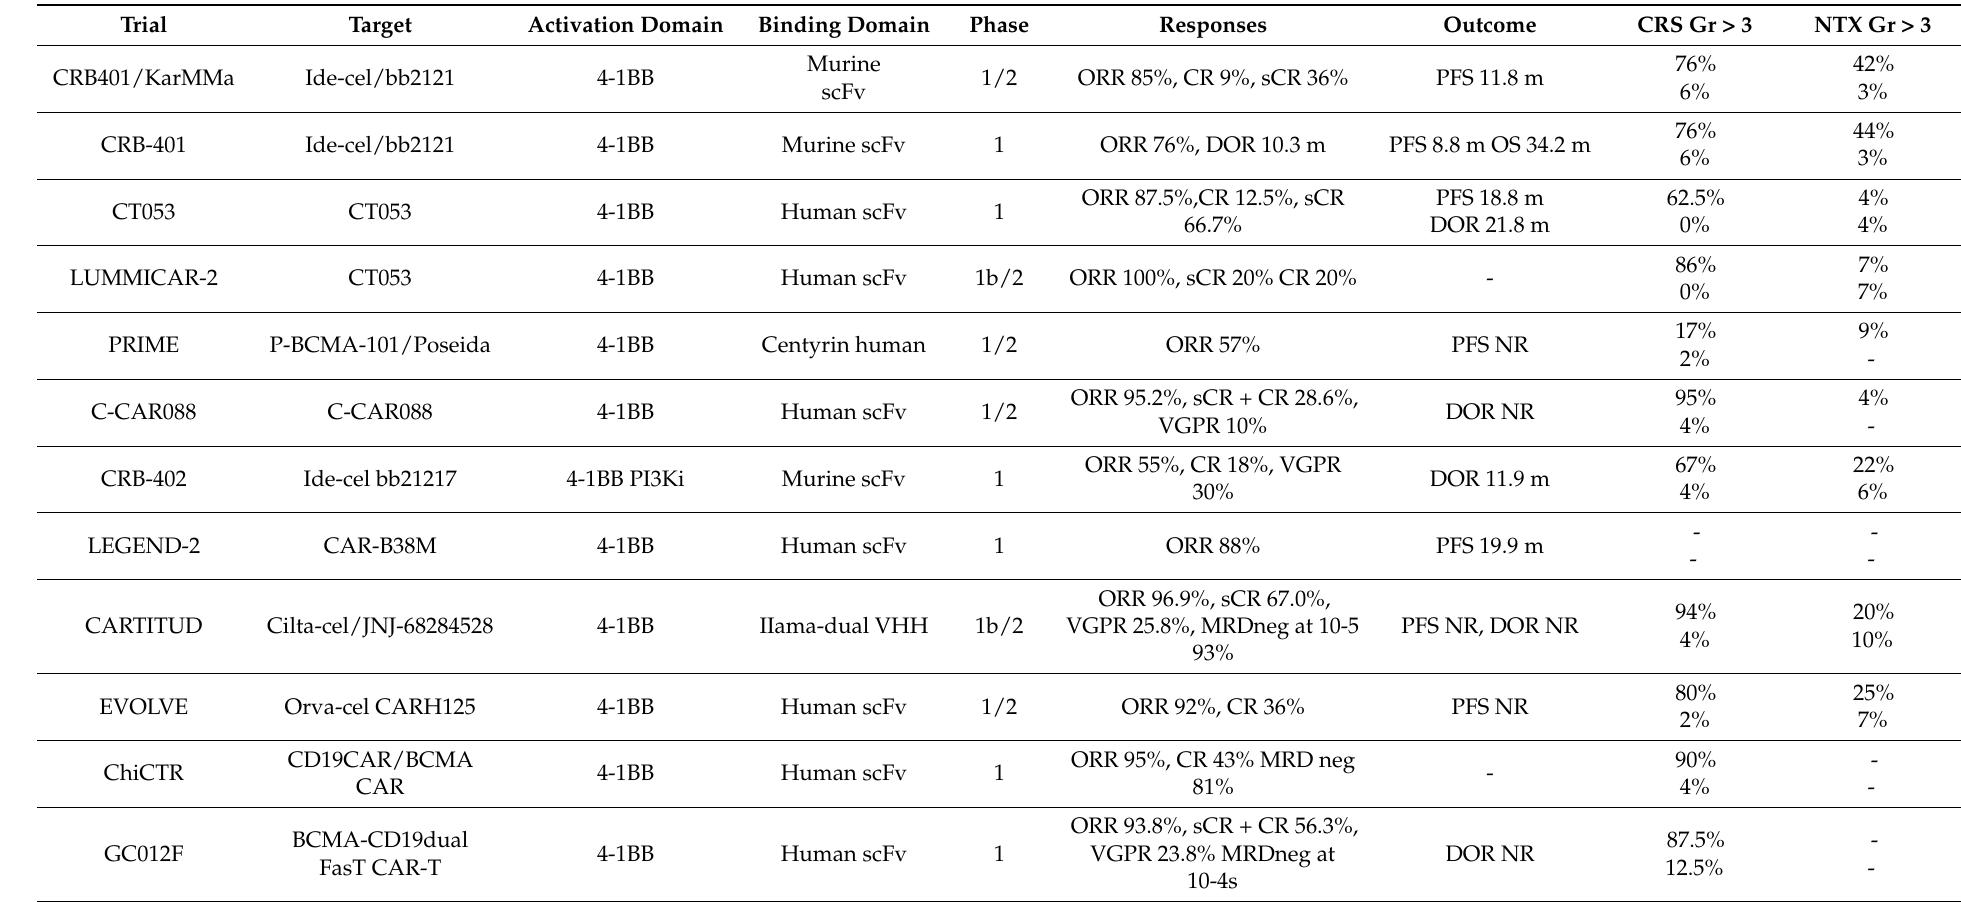
Table 5. BCMA-targeted CAR-T cell therapy in relapsed or refractory